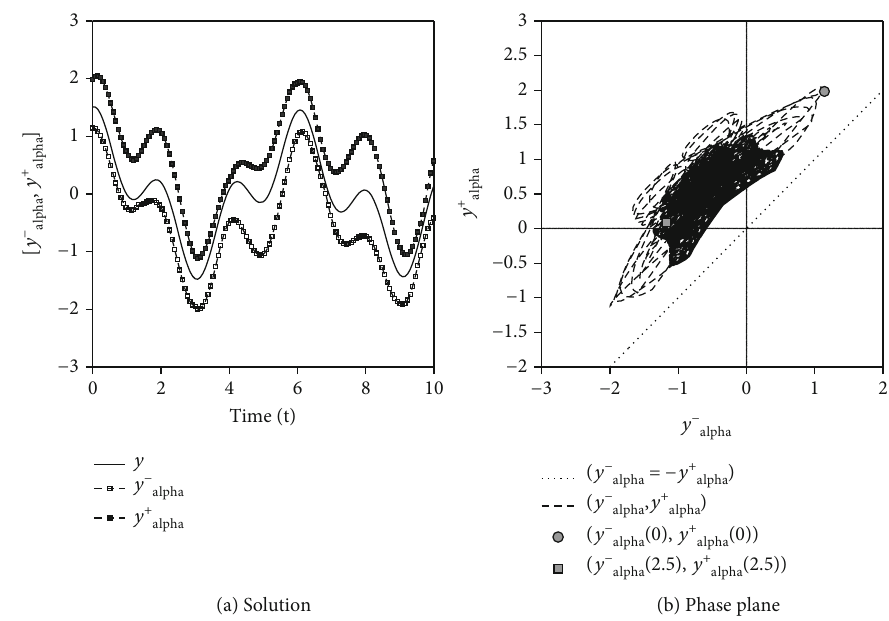
Figure 3: Graphs of Equation (30), i.e., the α − cut deterministic system which is obtained from applying the FDI concept. It is performed by solving Equation (29) using the extended RK method with the parameters which are in Equation (27) and the initial values which are in Equation (28). For (a) and (b), similar information as in Figures 1(a) and 1(b) are applied, except in (b), the dotted line states equation y − α = y + α .